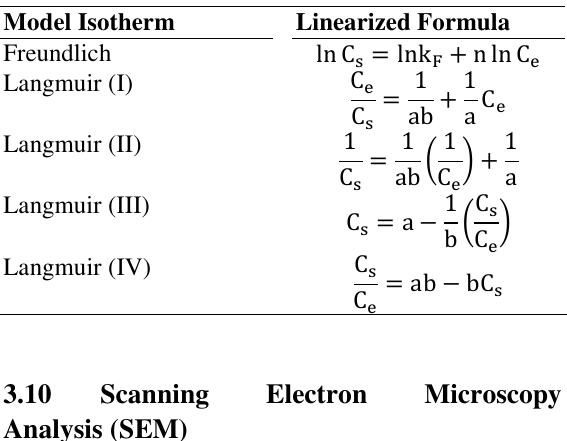
isotherm models used in the present study for the describing the uptake of Cr(III) onto ZVAI and